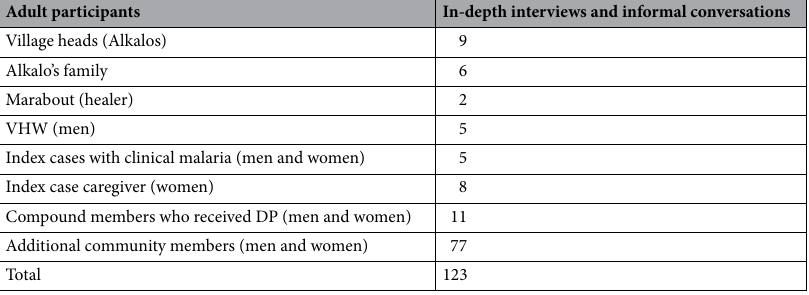
Table 1. Overview of respondents for in-depth interviews and informal